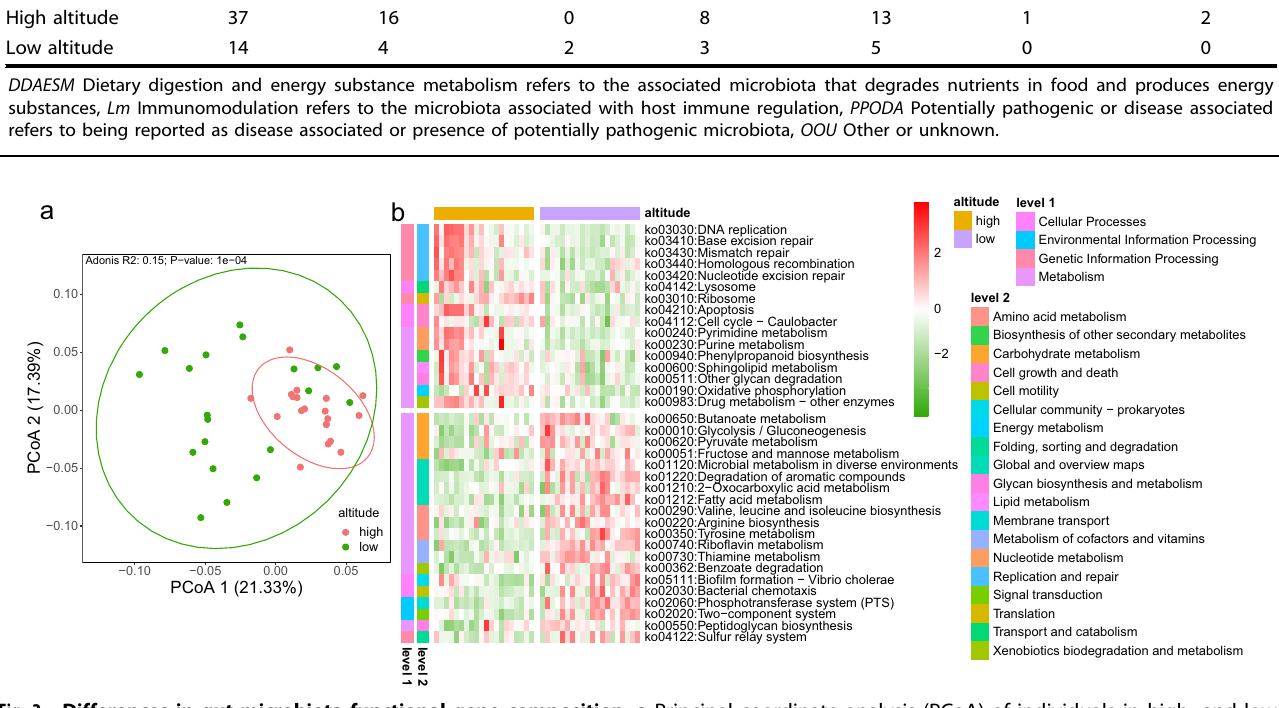
Fig. 2 Differences in gut microbiota functional gene composition. a Principal coordinate analysis (PCoA) of individuals in high- and low- altitude populations based on gut microbiota gene-family abundance (Bray – Curtis distance; Adonis test, R 2 = 0.15, P < 0.001), The ellipse borders represent the 95% con fi dence interval. b Heatmap showing the difference in functional enrichment rate of KEGG tertiary pathways of gut microbiota between high-altitude and low-altitude populations of RMs (LEfSe analysis, LDA > 2, P <